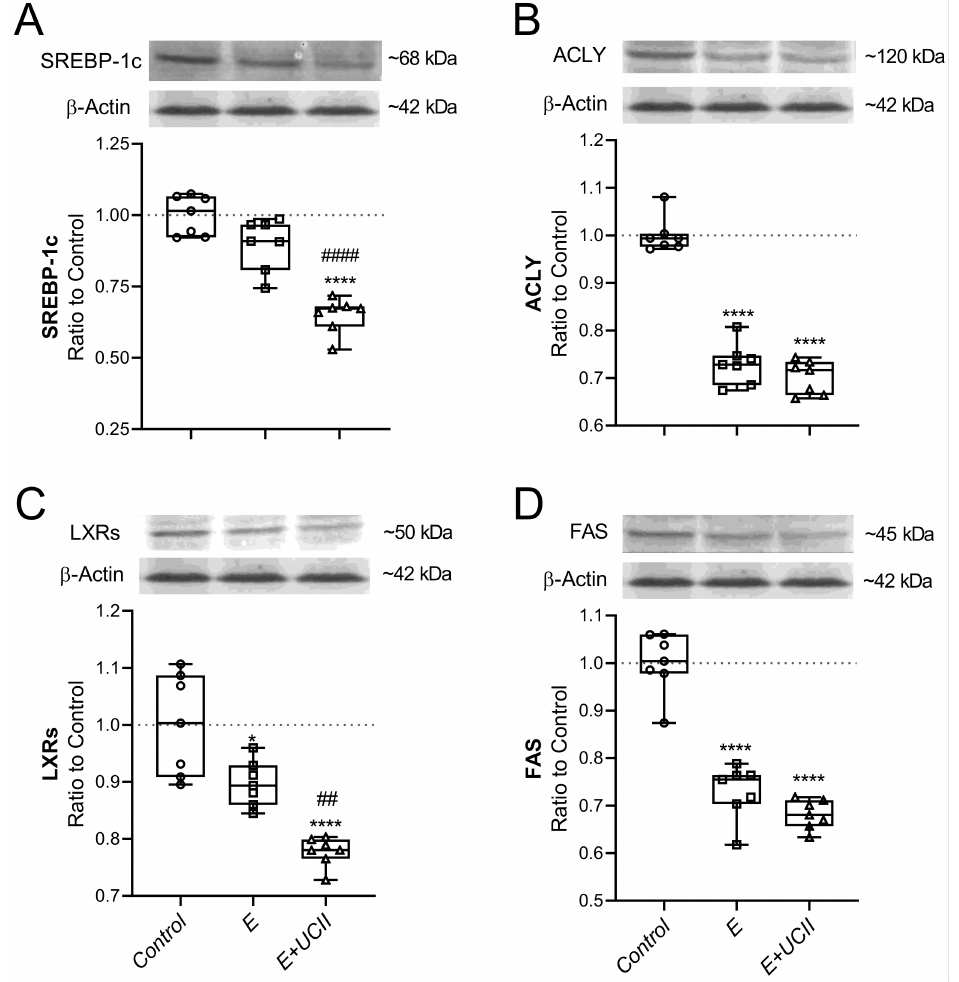
Figure 4. The effect of UCII on the muscle SREBP-1c ( A ), ACLY ( B ), LXRs ( C ), and FAS ( D ) levels in exercised rats. The densitometric analysis of the relative intensity according to the control group of the western blot bands (Figure S1) was performed with β -actin normalization to ensure equal protein loading. Blots were repeated at least three times ( n = 3), and a representative blot is shown. Box and Whisker plots show median, min, and max values. Data are expressed as a ratio of the control set at 1.0. ANOVA and Tukey’s post-hoc test were used to compare the results among different treatment groups. Statistical significance between groups is shown by: * p < 0.05; **** p < 0.0001 compared as control group and, ## p < 0.01; #### p < 0.0001 compared as exercise group. E: Exercise; UCII, Undenatured type II collagen; SREBP-1c, Sterol regulatory element-binding protein 1c; ACLY, ATP citrate lyase; LXRs, Liver X receptors; FAS, Fatty acid synthase, Control (Circle): no exercise and no UCII, E (Square): exercised rats, E + UCII (triangle), exercised rats receiving 4 mg/kg BW/day UCII. LXRs level was lower in E and E + UCII groups than the control group ( p < 0.05